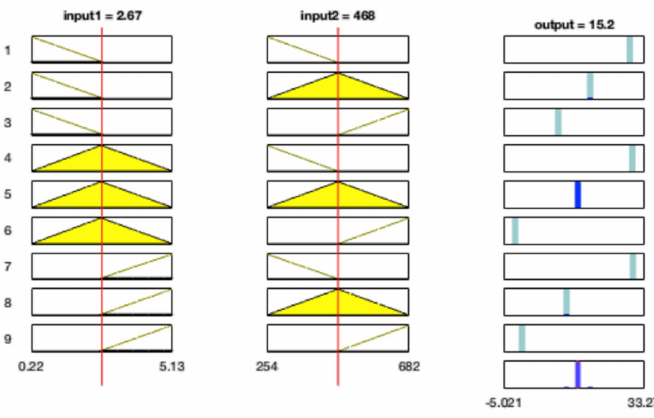
Figure 8. Proposed ANFIS rule viewer.